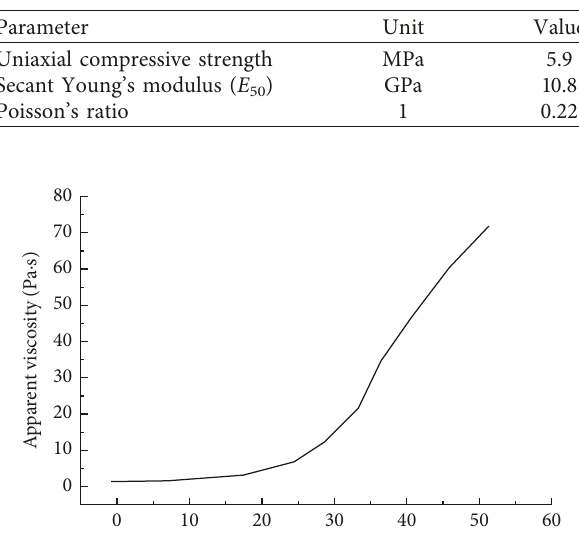
Table 4: Basic properties of cement-sodium silicate slurry.